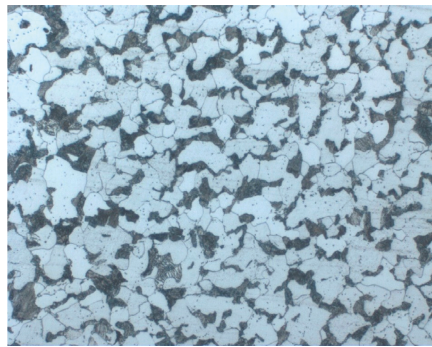
Figure 1: Microstructure of the pin is composed of ferrite and pearlite.